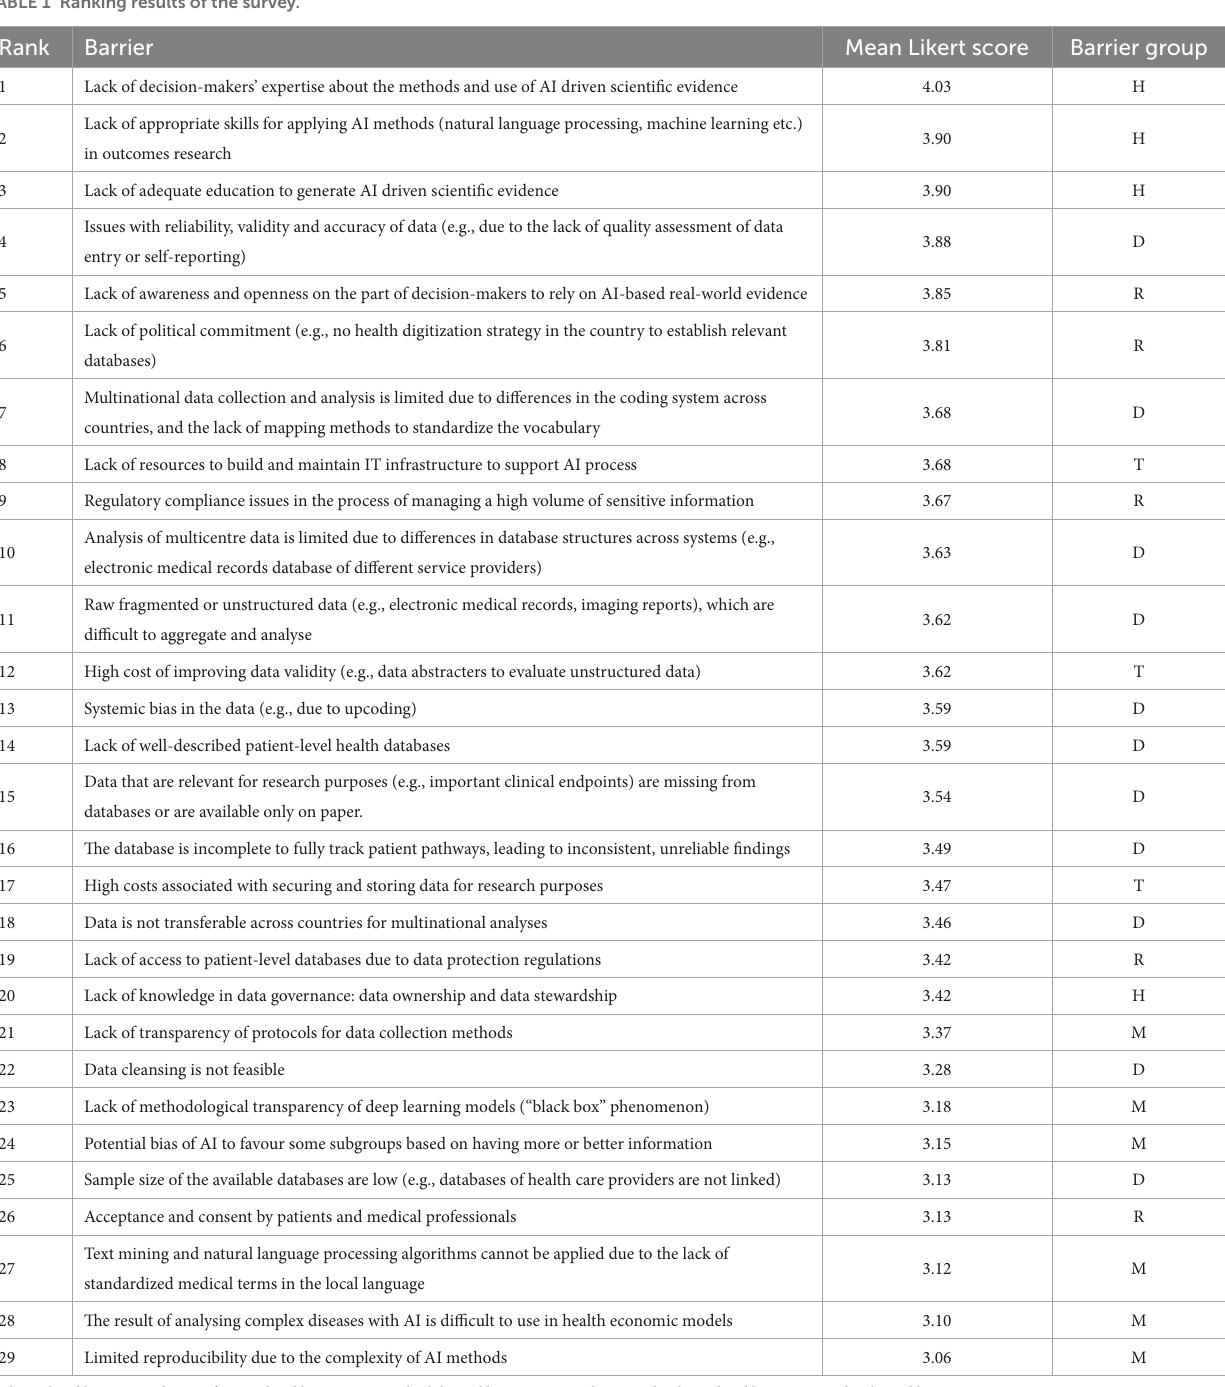
TABLE 1 Ranking results of the survey. Rank Barrier Mean Likert score Barrier